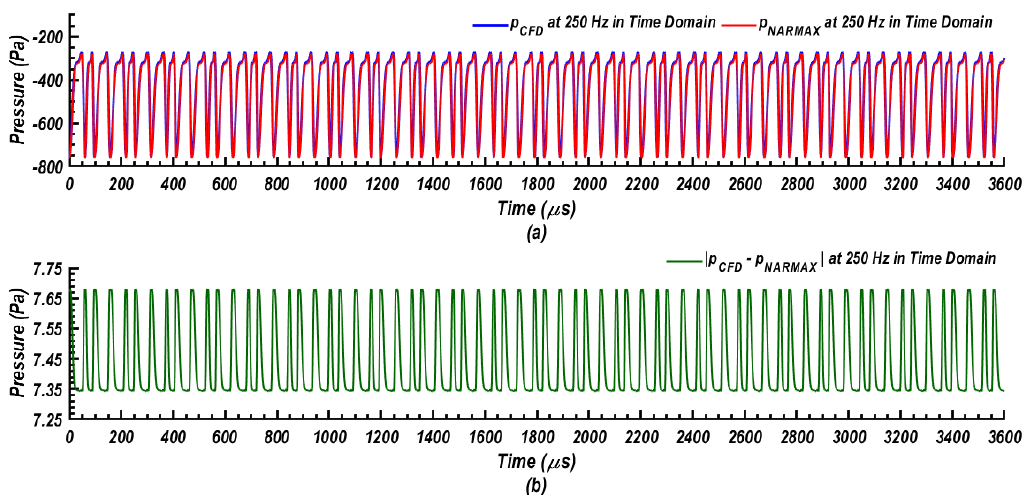
Figure 8. ( a ) Time variations of the observed and predicted pressure signals at 250Hz. ( b ) Time variation of the absolute difference between the observed and estimated pressure